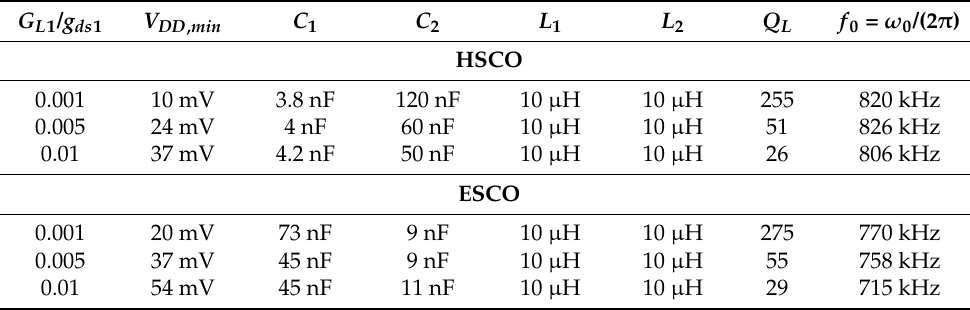
Table 1. Summary of parameters of ULV oscillators.